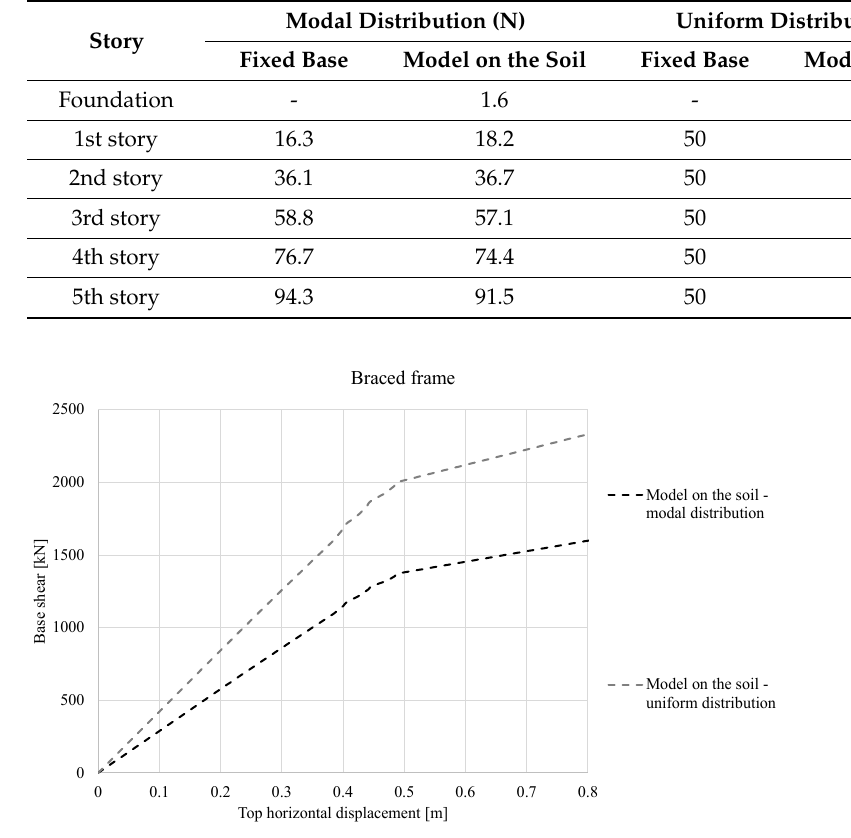
Figure 11. Numerically obtained results for the braced frame.